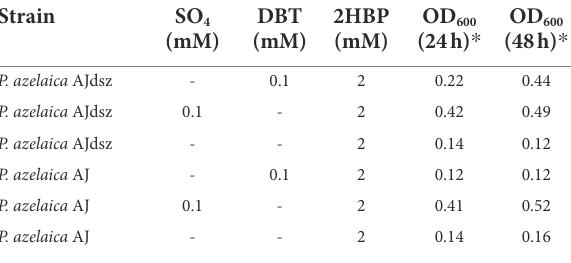
TABLE 2 Growth of P. azelaica AJ strains in BSM with 2HBP as a carbon source and SO 4 or DBT as a sulfur source.